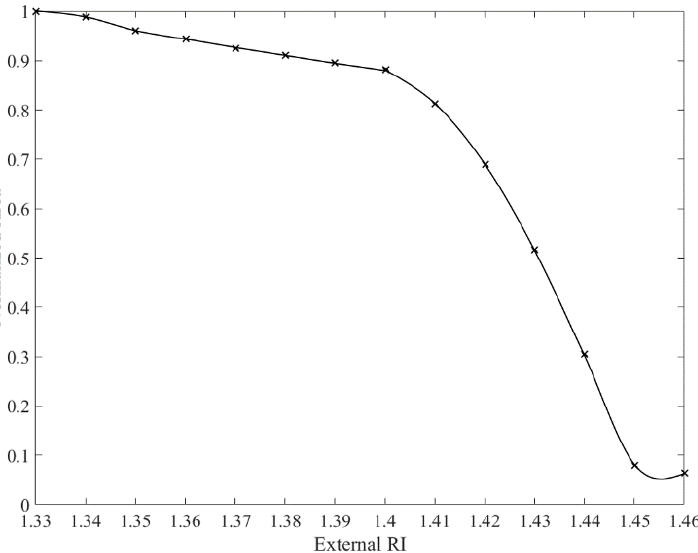
Figure 4. The correlation spline-curve between surrounding refractive indices (RIs) and cladding peaks envelope areas of the 3° tilted FBG.